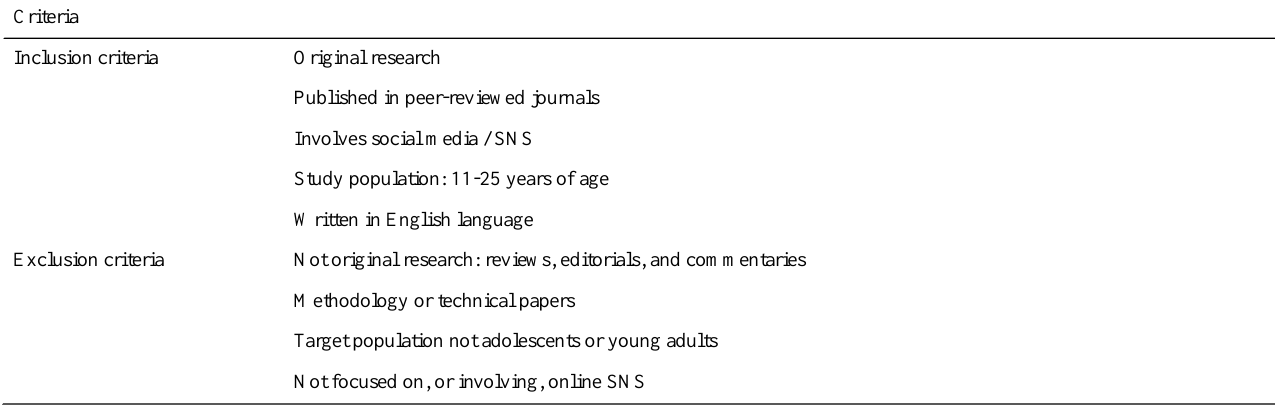
Table 1. Inclusion and exclusion criteria for systematic review. Criteria